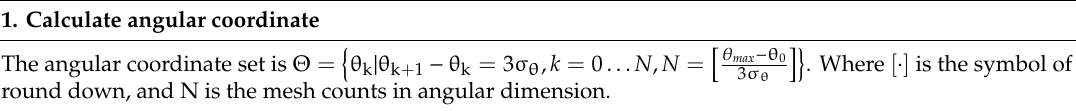
Table 1. The polar mesh grid calculation steps.